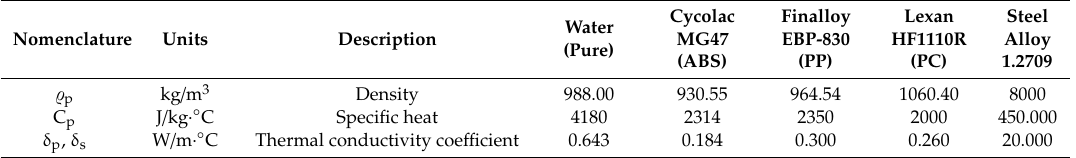
Table 5. Magnitude of the main properties of the materials used in the numerical simulations.